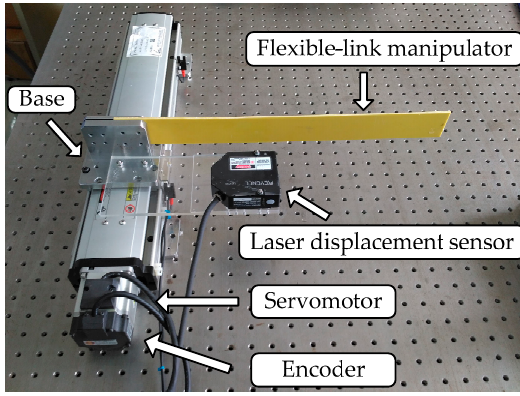
Figure 7. Photograph of the experimental setup.